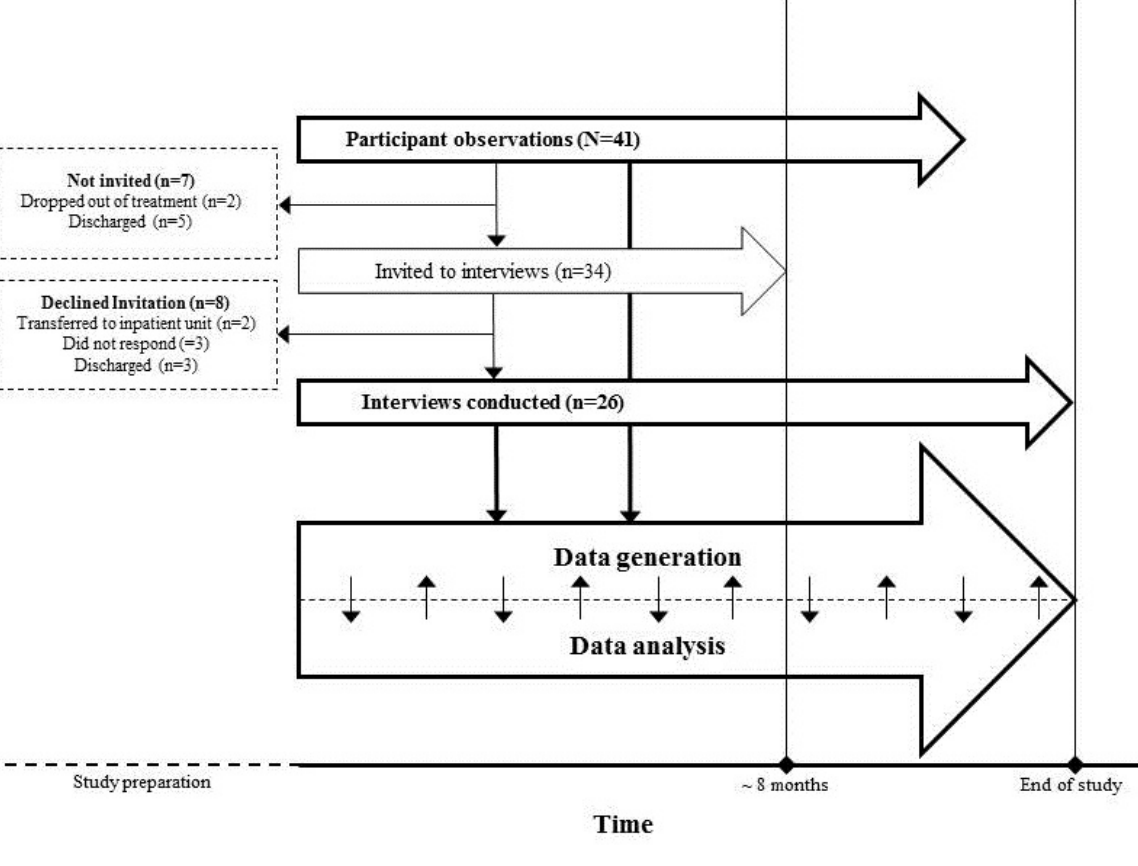
Figure 2. Illustration of participant flow and the concurrent data generation and analysis process. Specified in the boxed are the reasons why some participants were not invited to an interview or declined said